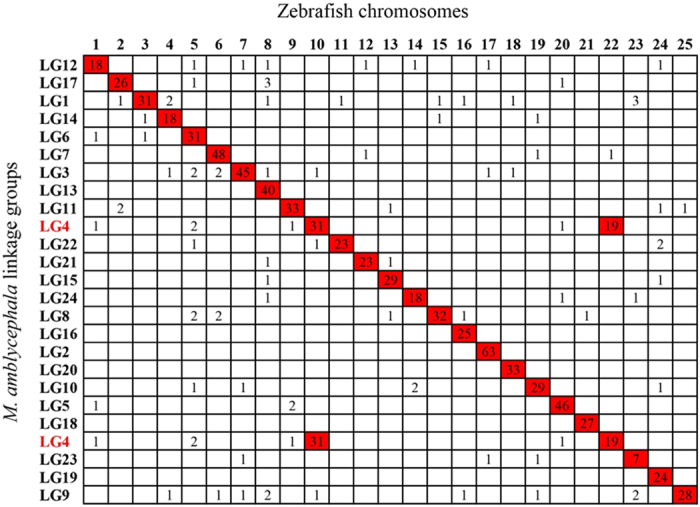
Homologous chromosome relationships between M. amblycephala and D. rerio.The numbers in the cells are the orthologous genes between M. amblycephala and D. rerio located on the designated chromosome (LG).